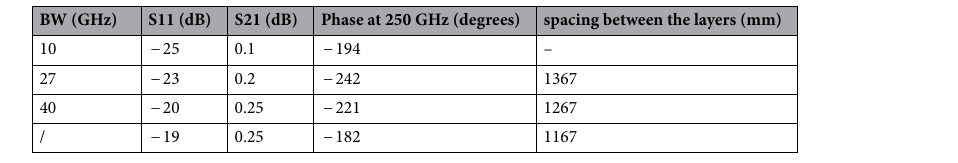
Table 2. Simulated unit cell performance parameters for TE